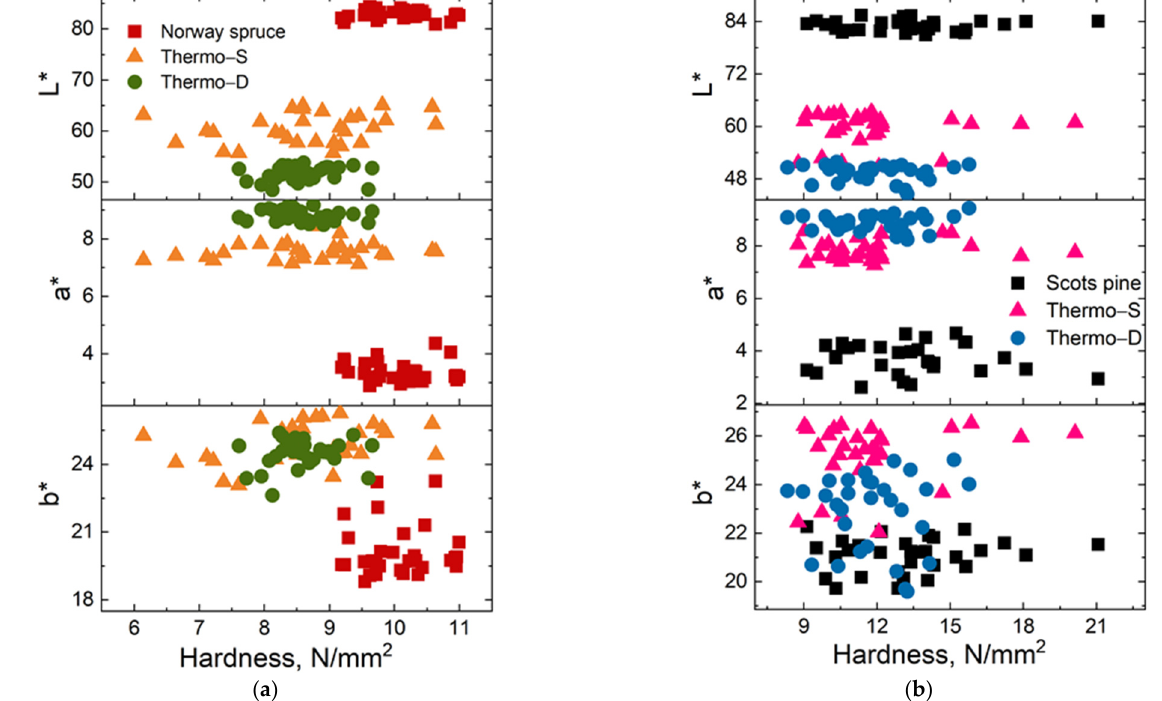
Figure 12. L*, a*, and b* parameters plotted as a function of Brinell hardness after release of force measured for the untreated and ThermoWood ® Norway spruce ( a ) and Scots pine ( b